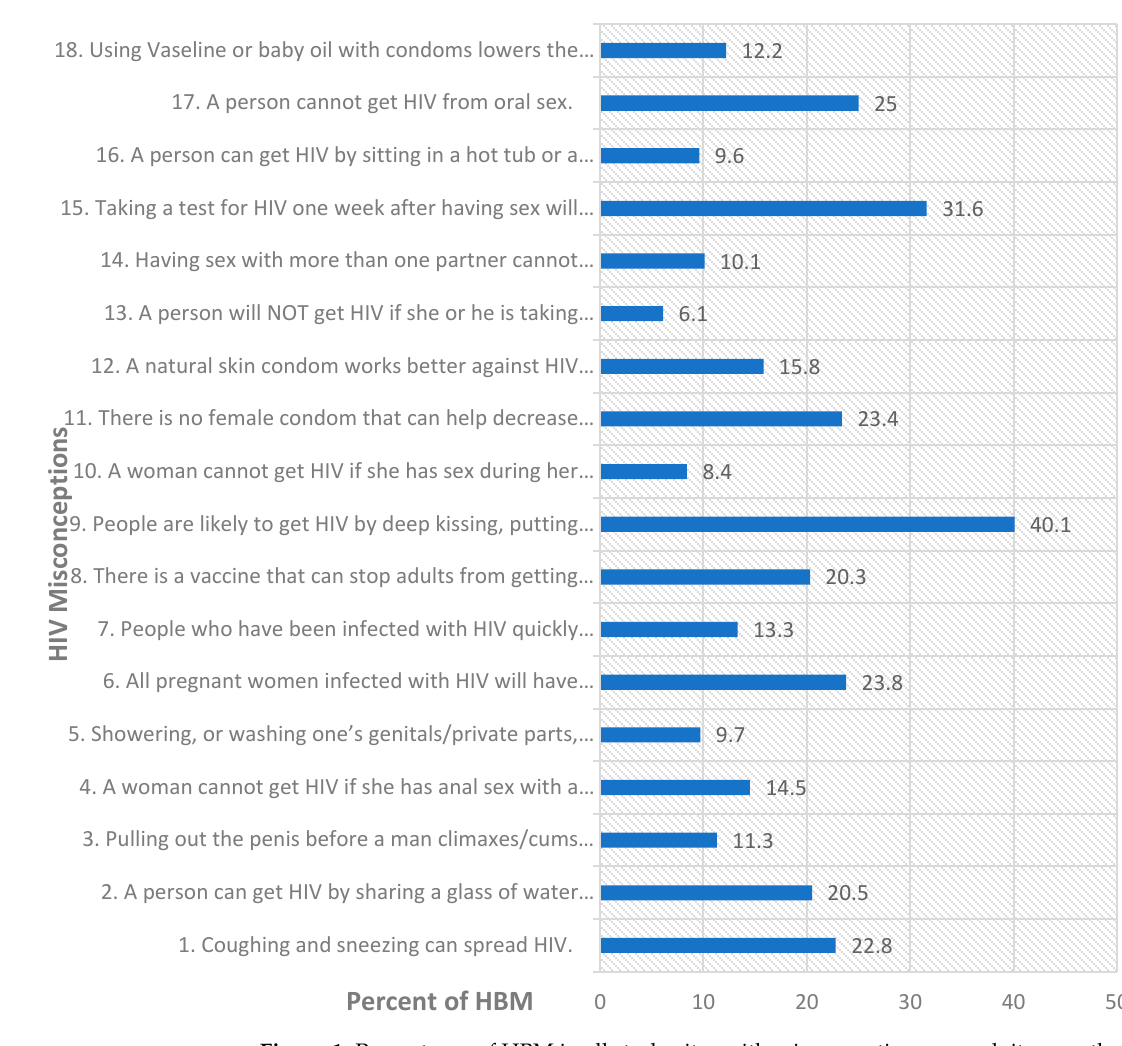
Figure 1. Percentages of HBM in all study sites with misconceptions on each item on the HIV-KQ-18. Table 3. Social Determinants of HIV Misconceptions: Results of Hierarchical Linear